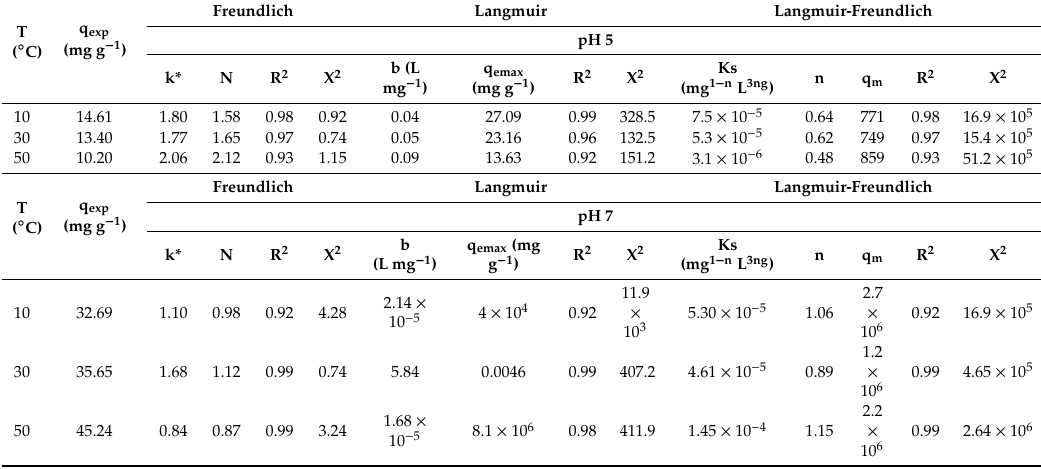
Table 2. Summary of adjustment of experimental data to adsorption isothermal